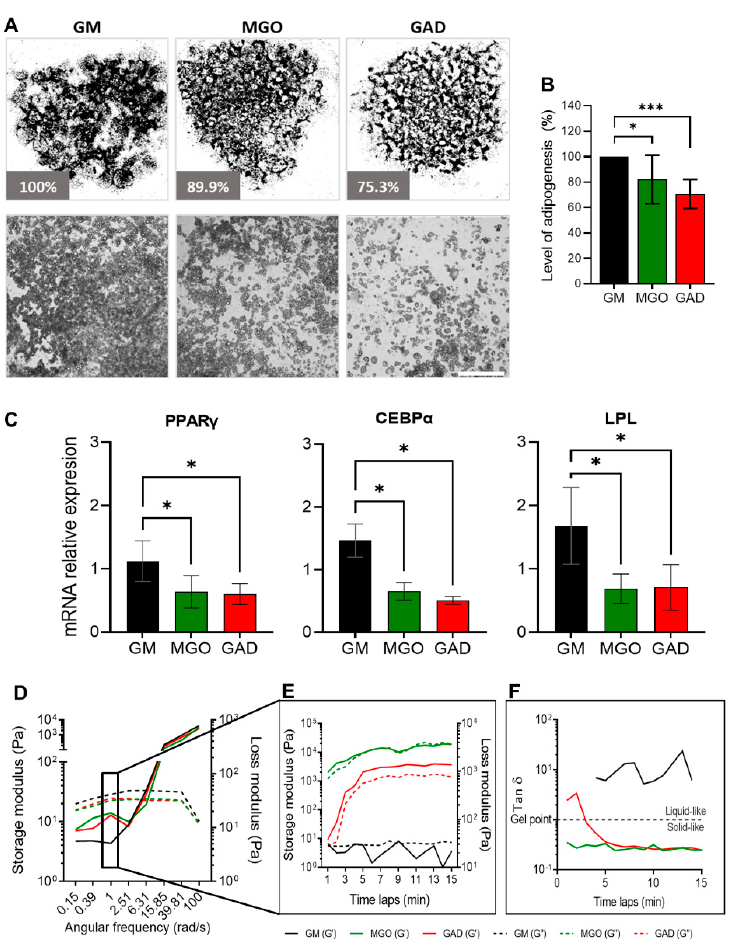
Figure 4. Adipogenesis under various hyperglycemic conditions, gene expressions, and stiffness changes. ( A ) LOA presented as a whole well stitching percentage analysis compared to GM of MGO- and GAD-treated cultures. Phase contrast representative culture images at ×40 (lower panel; scale bar = 650 µm). ( B ) LOA quantification analysis of MGO and GAD-treated adipocytes, compared to GM (n = 7). ( C ) The mRNA level of PPAR γ , CEBP α , and LPL relative to actin in MGO and GAD-treated adipocytes, compared to control (GM, n = 4). One-way ANOVA ± SD. ( D ) Rheology measurements of GM-control (black), MGO (green), and GAD (red) measuring the G’ (solid lines) versus G” (dash lines) as a function of angular frequency sweep between 0.1–100 rad/s. ( E ) Time- dependent measurement of a G’ versus G” was conducted under a constant frequency over 15 min. ( F ) Gel point (Tan δ ) measured by the loss and storage modulus ratio over time. (* p < 0.05, *** p <